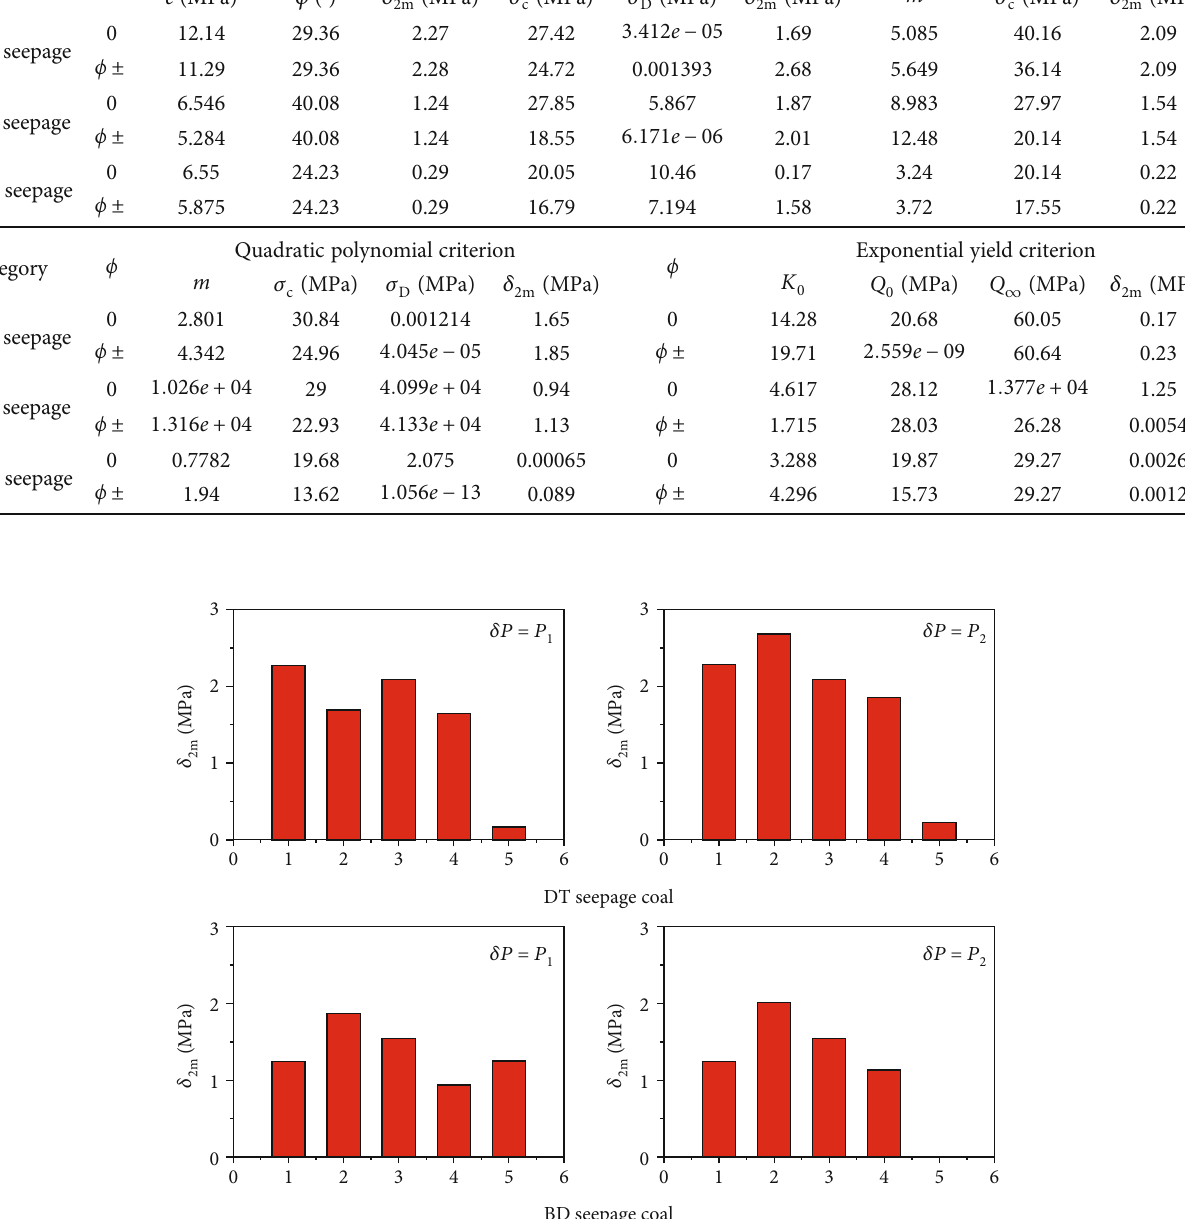
Table 5: Triaxial strength fi tting results of fi ve types of e ff ective strength criteria for coal during a seepage process based on the least absolute. Category